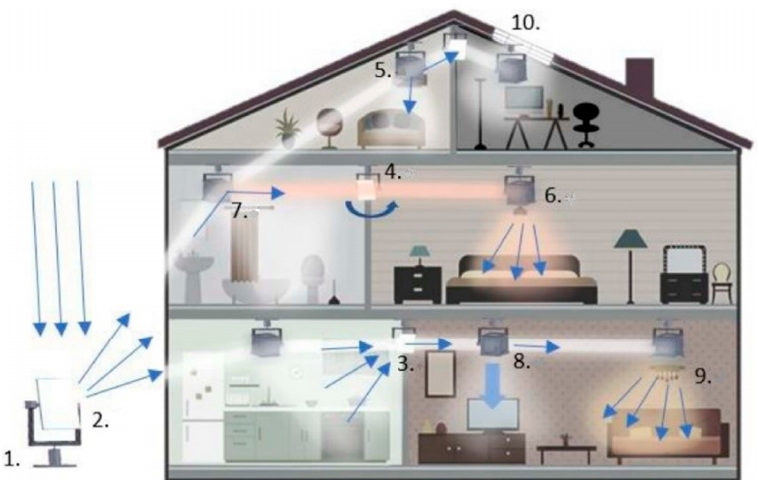
Figure 1. Various modules expected in the future. 1. heliostat; 2. light-collecting module; 3. collimat- ing module; 4. reflecting module; 5. beam-splitting module; 6. coupling module; 7. color separation module; 8. light convergent module; 9. emission module; and 10. accumulation module (solar